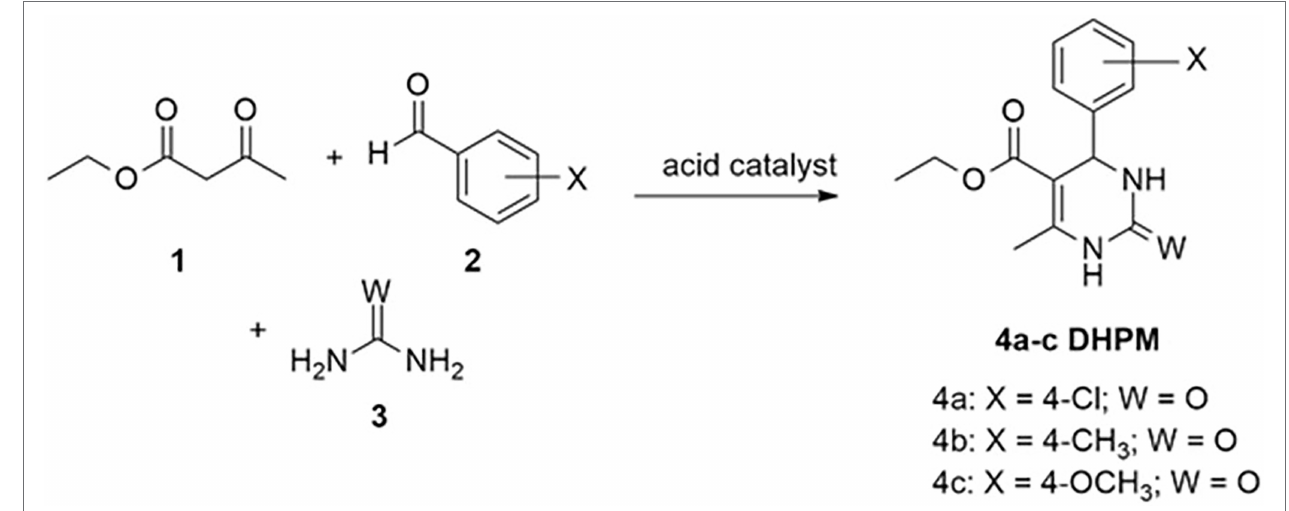
FIGURE 1 | Biginelli reaction and formation of the compounds of